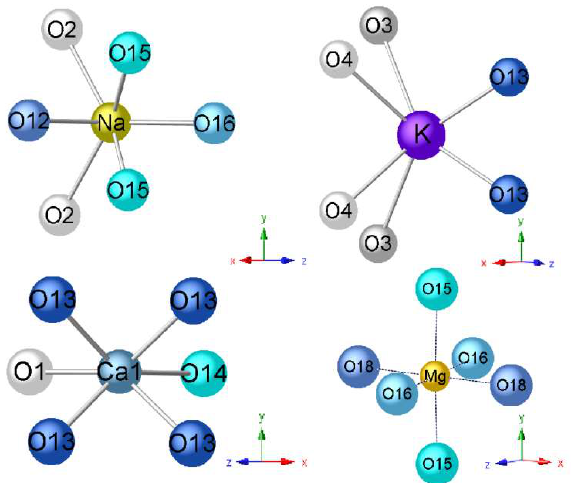
Figure 8. Outgoing cations coordination (2h of exchange).